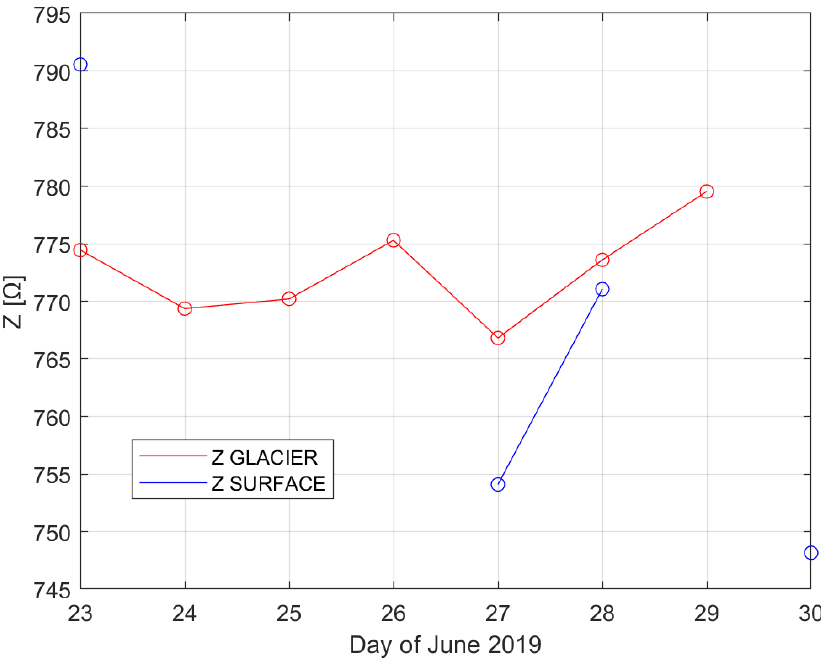
Figure 7. The calculated approximate impedances of the inside-glacier- and surface antennas.